Question: From the figure, is the trend upward or downward?
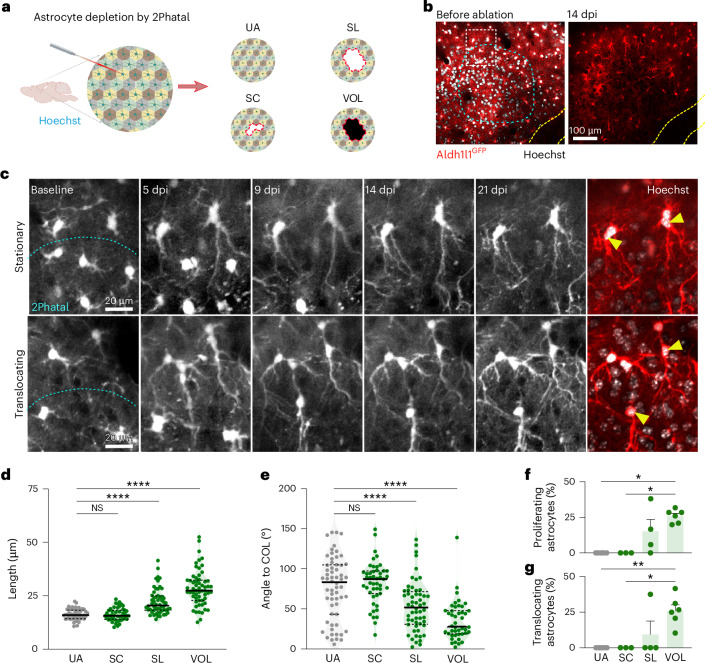
Answer: increasing